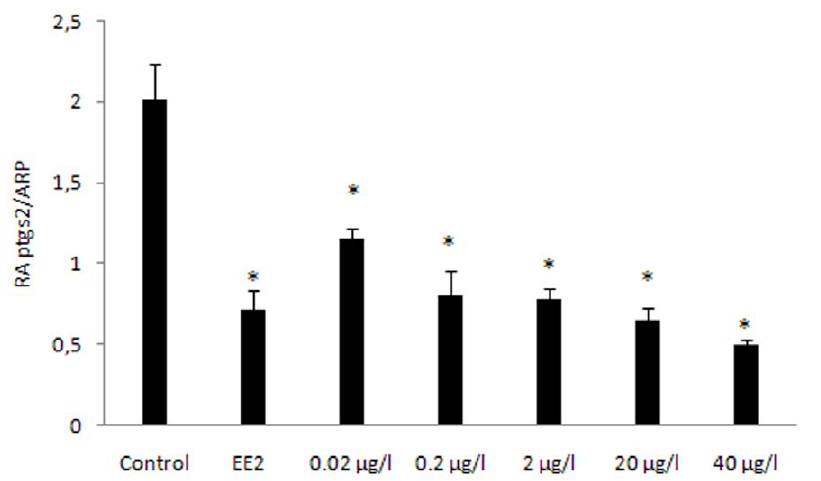
Figure 5. Inhibition of DEHP on ovarian ptgs2 gene expression. Female zebrafish were exposed to EE2 (25 ng/l), or DEHP at doses of 0.02, 0.2, 2, 20 or 40 m g/l. The expression of ptgs2 gene was normalized using ARP gene. Data were shown as mean 6 SD. Asterisks* indicate statistical significant differences compare to control group (p , 0.05).